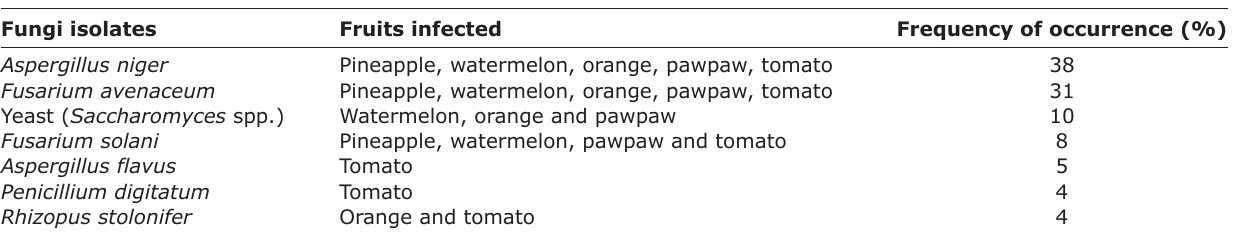
Table-1: Frequency of occurrence of fungal species. Fungi isolates Fruits infected